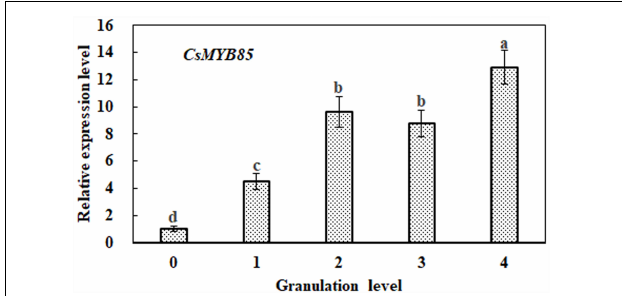
FIGURE 2 | Relative expression of the CsMYB85 gene at different stages of citrus fruit granulation. CsMYB85 expression was determined by real-time qRT-PCR and normalized to the CsActin reference gene. Means were obtained from four biological replicates. Error bars represent standard errors and were determined using Duncan’s multiple range test ( α = 0.05) in SAS software (SAS Institute, Cary, NC, United States). The ‘a–d’ above each column indicates P < 0.05 and the same letter indicates that the difference is not significant.